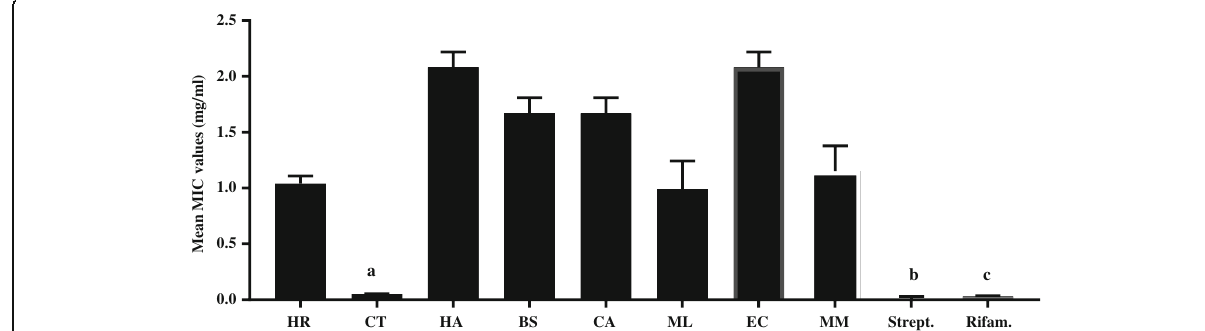
Fig. 1 The mean MIC values (mg/ml) of acetone leaf extracts of the different medicinal plants and the positive controls (Streptomycin and Rifampicin) against M. smegmatis , M. fortuitum and M. aurum. Legend: a, b and c = no statistical significant difference in the mean MIC values, p < 0.05. HR = Hypericum roeperianum , CT = Cremaspora triflora , HA = Heteromorpha arborescens , BS = Bolusanthus speciosus, CA = Calpurnia aurea , ML = Maesa lanceolata , EC = Elaeodendron croceum , MM = Morus mesozygia, Strept. =Streptomycin, Rifam. = Rifampicin